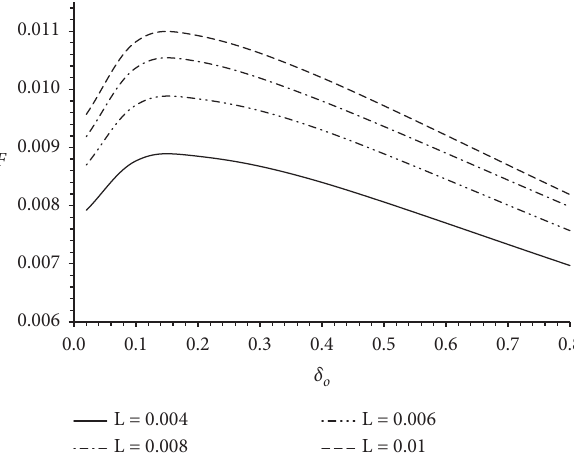
Figure 12: F vs δ o at different channel heights for case O at E K r � 10, χ 2 � 0.5.